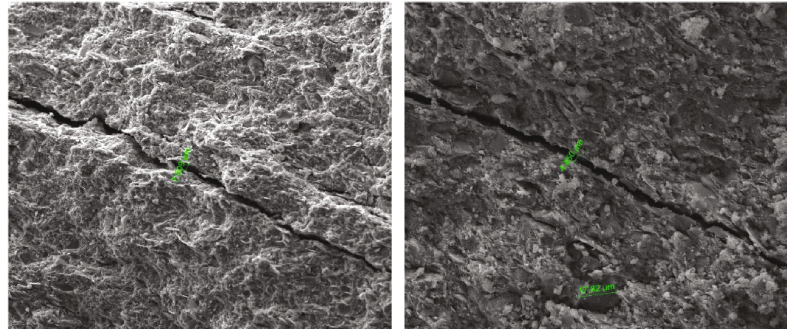
Figure 1: Characteristics of microbedding fractures in reservoir shale.